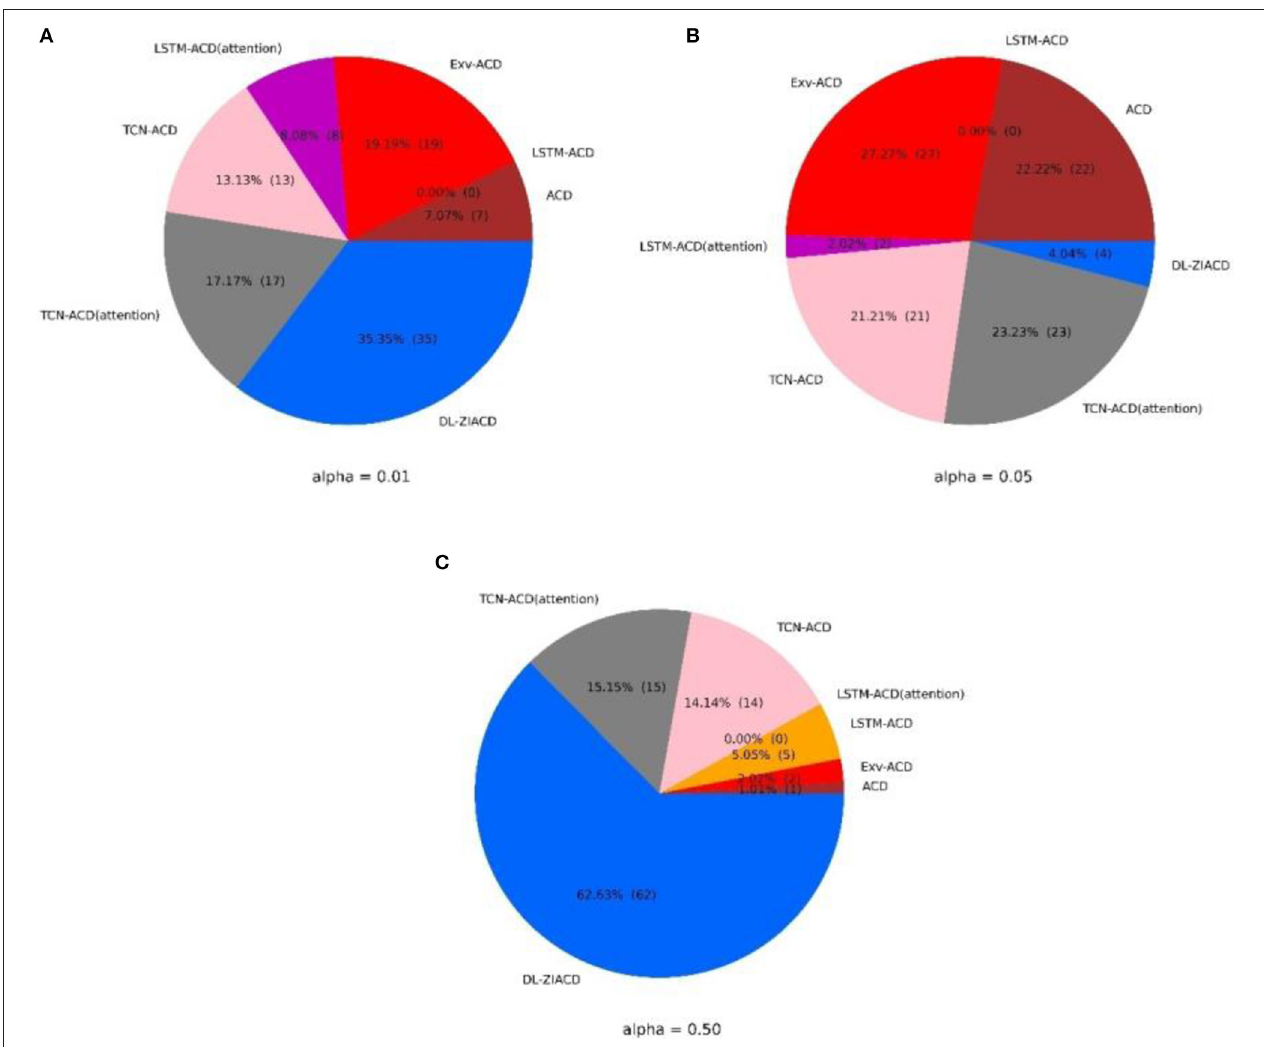
FIGURE 5 | Detailed comparison of the seven models in QL α by a pie chart [the size of each pie slice represents the percentage (number) of stocks on which the corresponding model achieves the lowest QL α ].